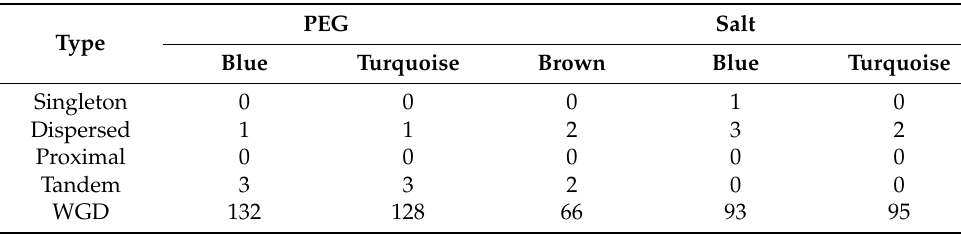
Table 2. The prediction of the duplicated TFs in different